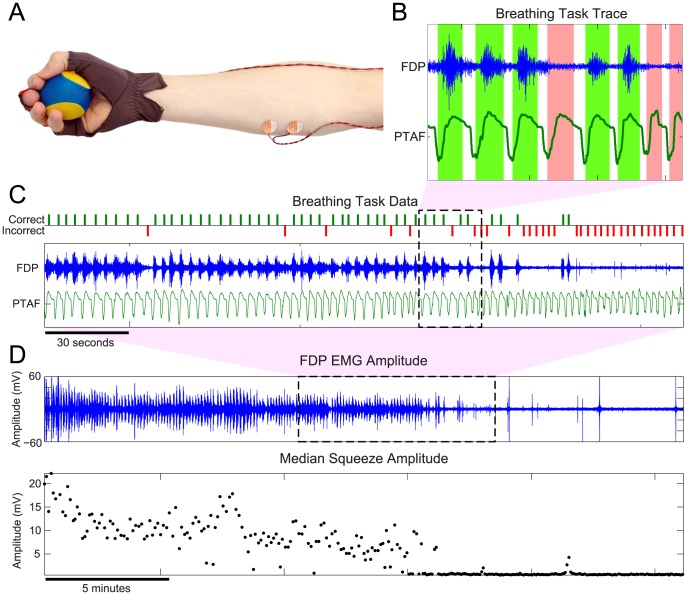
Tracking the sleep onset process with a behavioral task mediated by breathing.(A) In addition to a high-density EEG cap and standard PSG sensor array, subjects were fitted with a force-sensing glove, bipolar EMG electrodes on their flexor digitorum profundus (FDP), and a small gel-filled stress ball. Subjects were instructed to breathe normally with eyes closed as they fell asleep, and to gently squeeze the stress ball on each inhale, releasing it on each exhale. (B) Times at which a squeeze was aligned with a corresponding inhale were scored as correct trials (green regions). Times with an inhale and no squeeze (or a misaligned squeeze) were scored as incorrect trials. (C) By scoring this task across the sleep initiation period, we can track behavioral dynamics during the transition from wake to sleep, without using any external task stimuli that could produce arousal. (D) EMG amplitude during squeezes decays during the SOP. Over the course of the experiment, the FDP traces (top panel) were processed to extract the median amplitudes of each squeeze (bottom panel), which can be used as a correlate of wakefulness during the SOP.